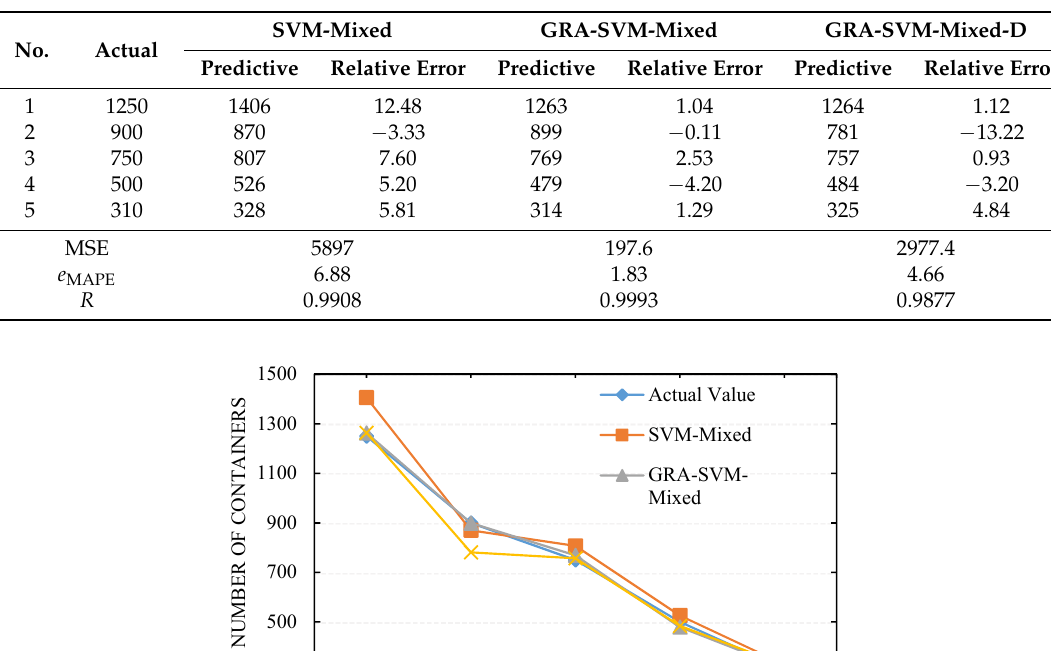
Table 5. Comparison of predictions for different input variables.